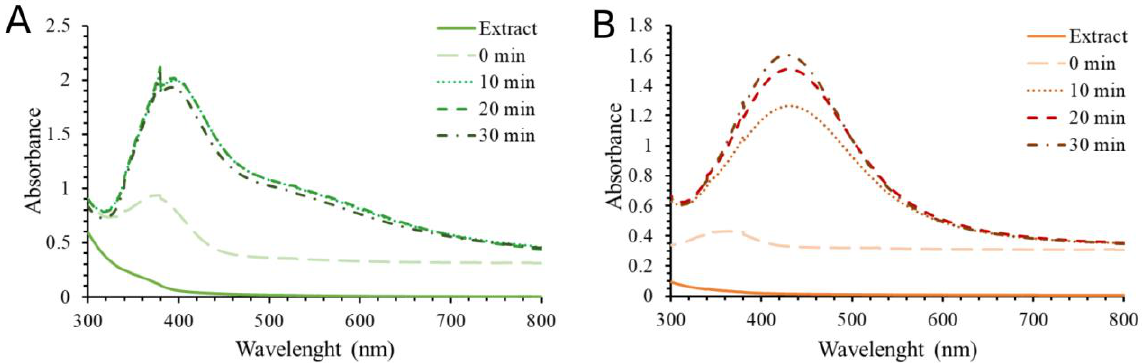
Figure 3. Time-dependent UV – Vis absorption spectra of ( A ) SPA-AgNPs and ( B ) SPR-AgNPs ob- tained under the optimal conditions. tained under the optimal